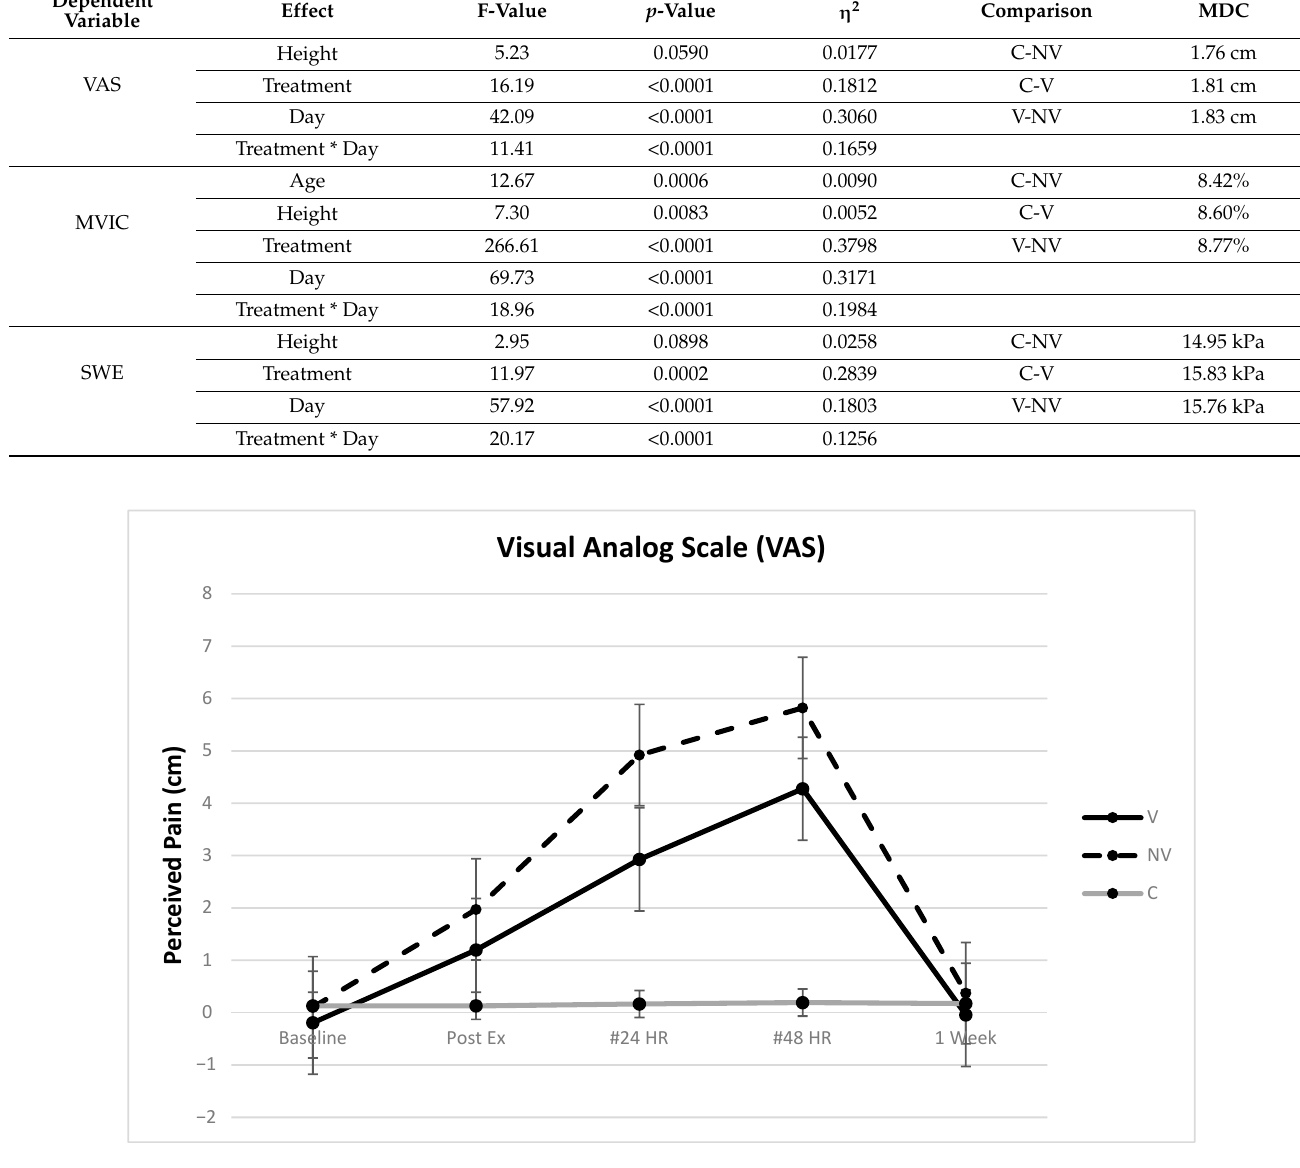
Figure 4. Perceived pain ratings using a visual analog scale. # = Control different from treatment groups (bars represent the 95% confidence interval values). Table 1. Significance and Eta2 of effects analyzed in the final model for each dependent variable. Minimal detectable change (MDC) scores are calculated for group comparisons for each dependent variable at the 0.01 significance level.